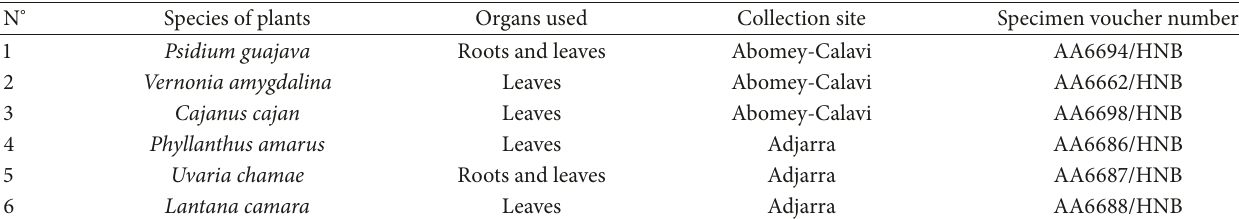
Table 1: Composition of plant